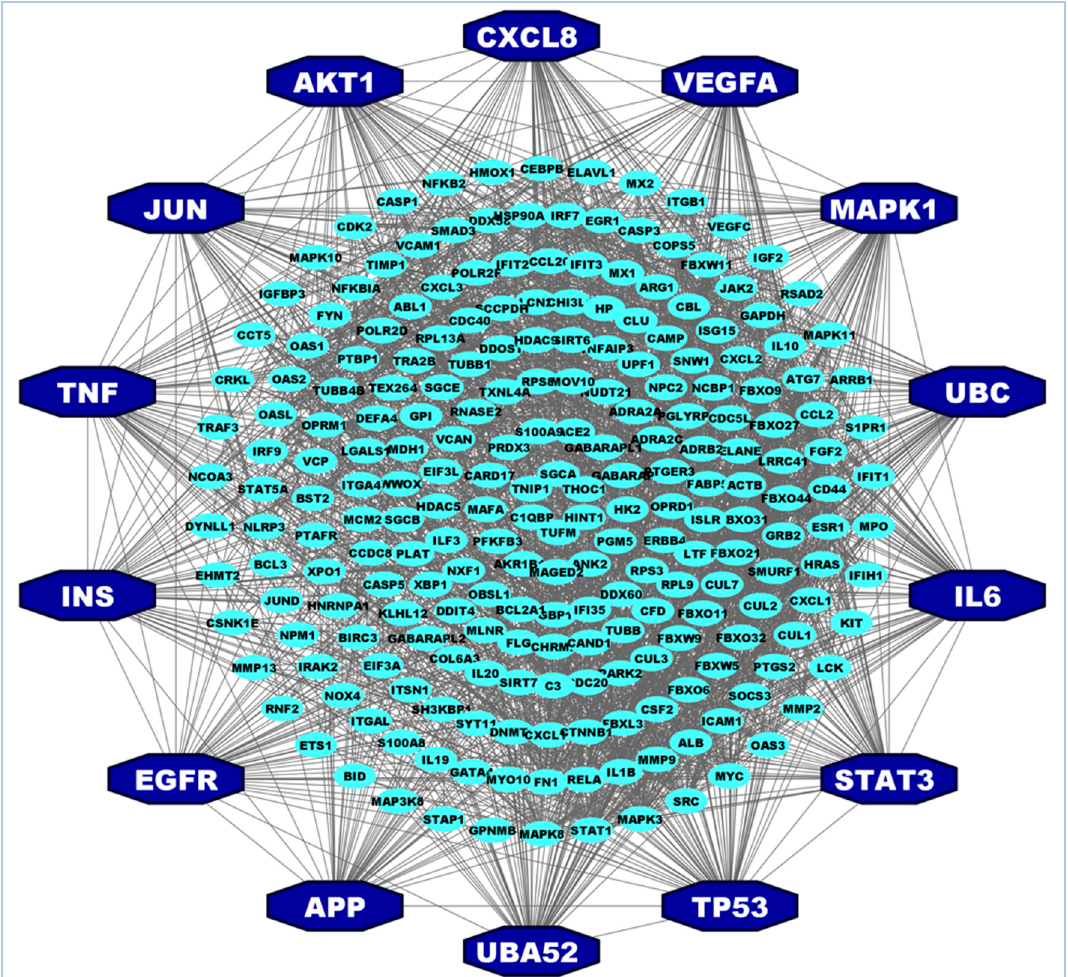
Figure 2. Protein–protein interaction (PPI) network analysis of Hub-DEGs-detected hHub-DEGs. The nodes in octagon shape with a blue color indicate the hHub-DEGs and a small ellipse indicates hub DEGs.